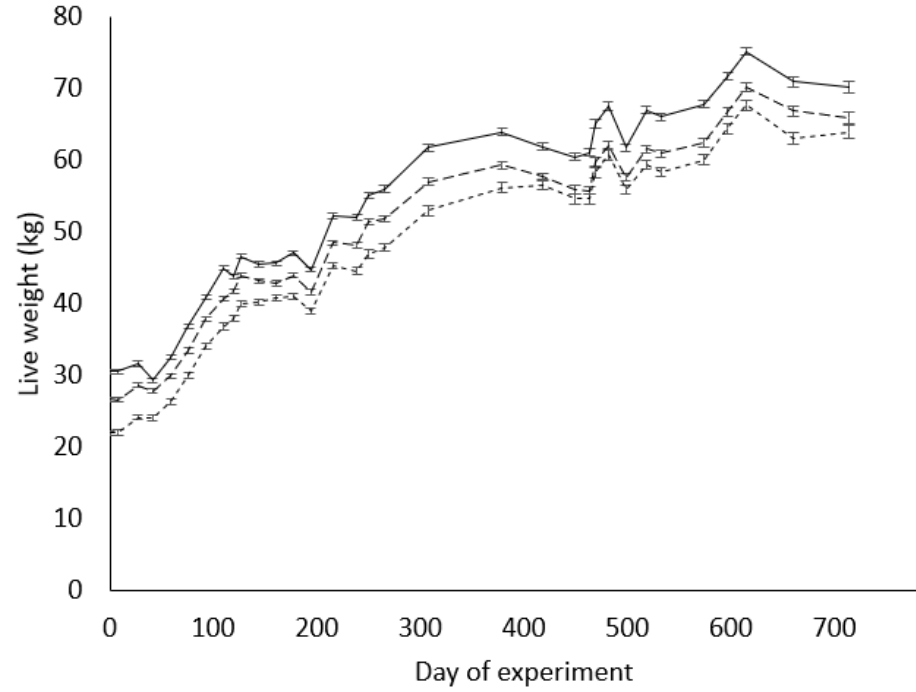
Figure 1. Least-squares means (error bars of ± S.E.M.) of live weight (kg) of ewes born to mature ewes as twins (M2; ― ), or born to ewe lambs as singletons (L1; – –) or as twins (L2; ---) from their weaning (D0) to the weaning of their second lambs (D714).